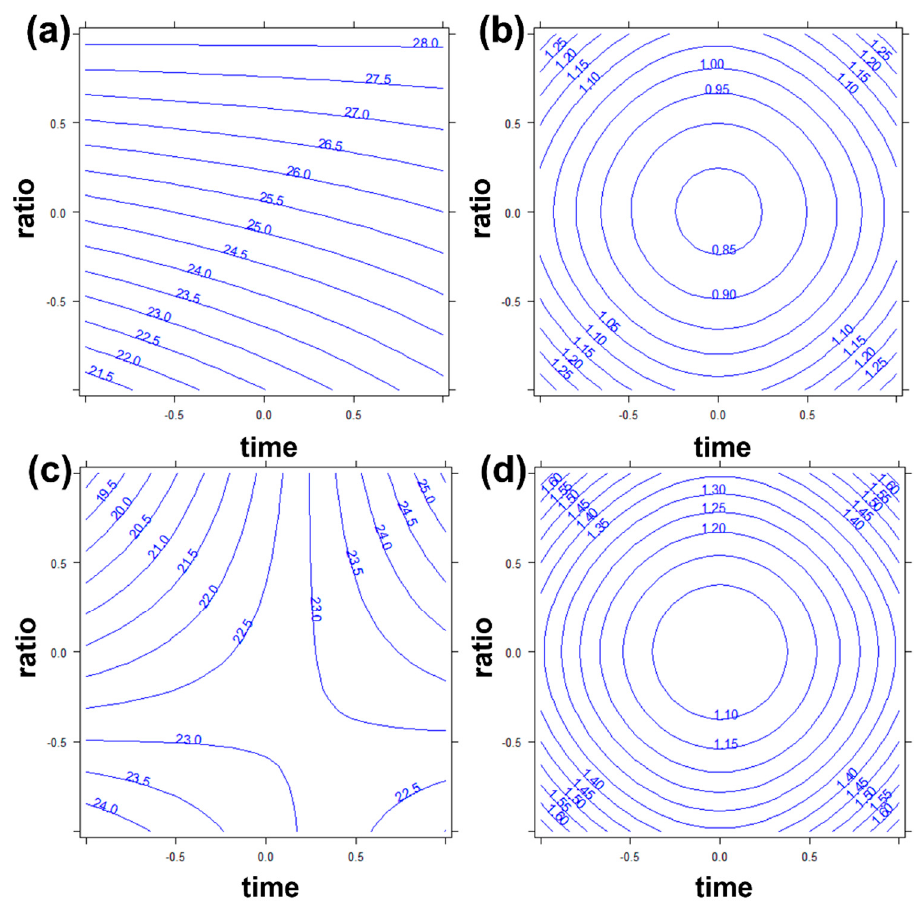
Figure 2. ( a ) Response surface and ( b ) semiamplitude of the 95% confidence interval for Merlot red GP model and ( c ) response surface and ( d ) semiamplitude of the 95% confidence interval for Garganega white GP model. Factors time and ratio are reported in abscissa and ordinate respectively. Enzyme type was kept to Pentopan level. The axis scale ±1 is due to DoE levels.